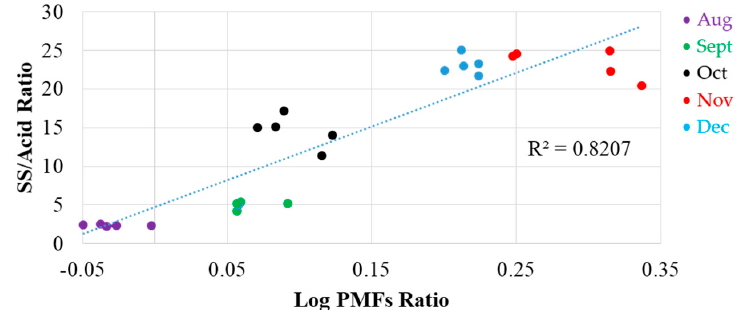
Figure 6. Correlation between log of the ratio of polymethoxyflavones (PMFs) (Ex 370 nm/Ex 260 nm) and SS/acid ratio.